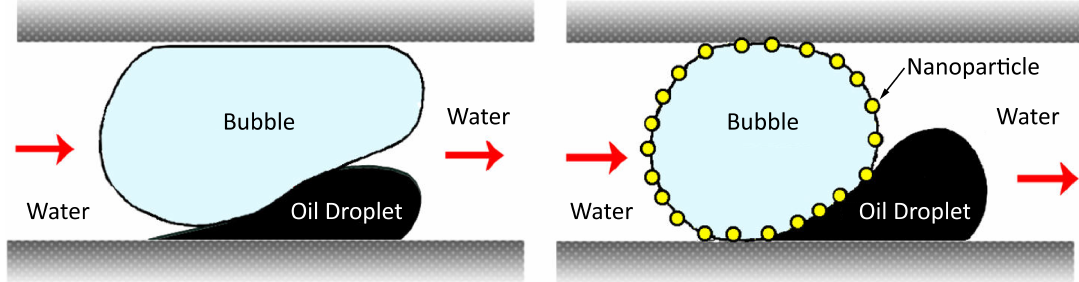
Figure 23. Difference between the displacement of an oil droplet on a pore wall using SDS foam ( left ) and SiO 2 /SDS foam ( right ). Figure reproduced from Ref. [109].